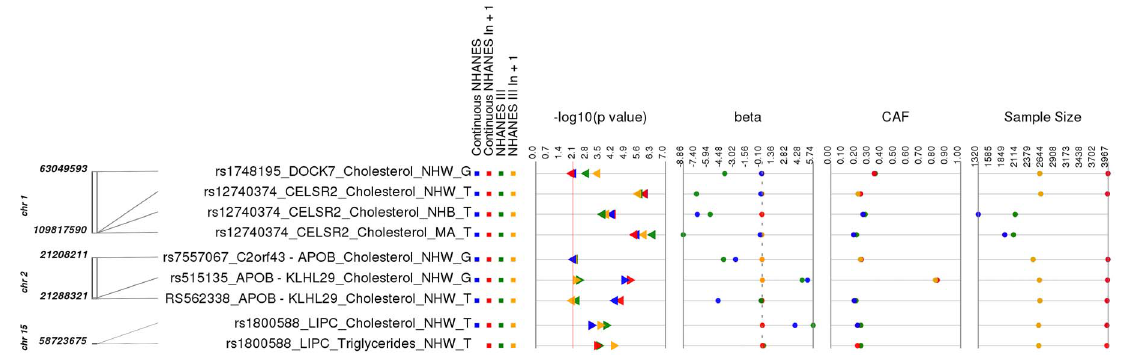
Fig. 3. Related results for PheWAS. This is a plot of SNP-phenotype associations observed in both NHANES III and Continuous NHANES with p- value , 0.01, for SNPs with an allele frequency . 0.01, and a sample size . 200, for the same race-ethnicity, phenotype-class, and direction of effect. Plotted are results where the significant SNP-phenotype association is closely related to the phenotype of a previously reported SNP-Phenotype association. The first column indicates the chromosome and bp location of the SNP. The second column indicates the SNP ID, the associated phenotype-class, the self-reported race-ethnicity (NHW = Non-Hispanic Whites, NHB = Non-Hispanic Blacks, or MA = Mexican Americans), and the coded-allele. The next column contains a colored box if association results were available for natural log transformed Continuous NHANES phenotypes (Continuous NHANES ln + 1), un-transformed Continuous NHANES phenotypes, NHANES III untransformed phenotypes (NHANES III), or transformed NHANES III phenotypes (NHANES III ln + 1) (see methods for more details on phenotype transformation). The next column indicates the p- value for each association, and the triangle direction indicates whether the association had a positive (triangle pointed to the left) or negative direction of effect (triangle pointed to the right). The following columns indicate magnitude of the effect (beta), the coded allele frequency (CAF), and the sample size for the association.